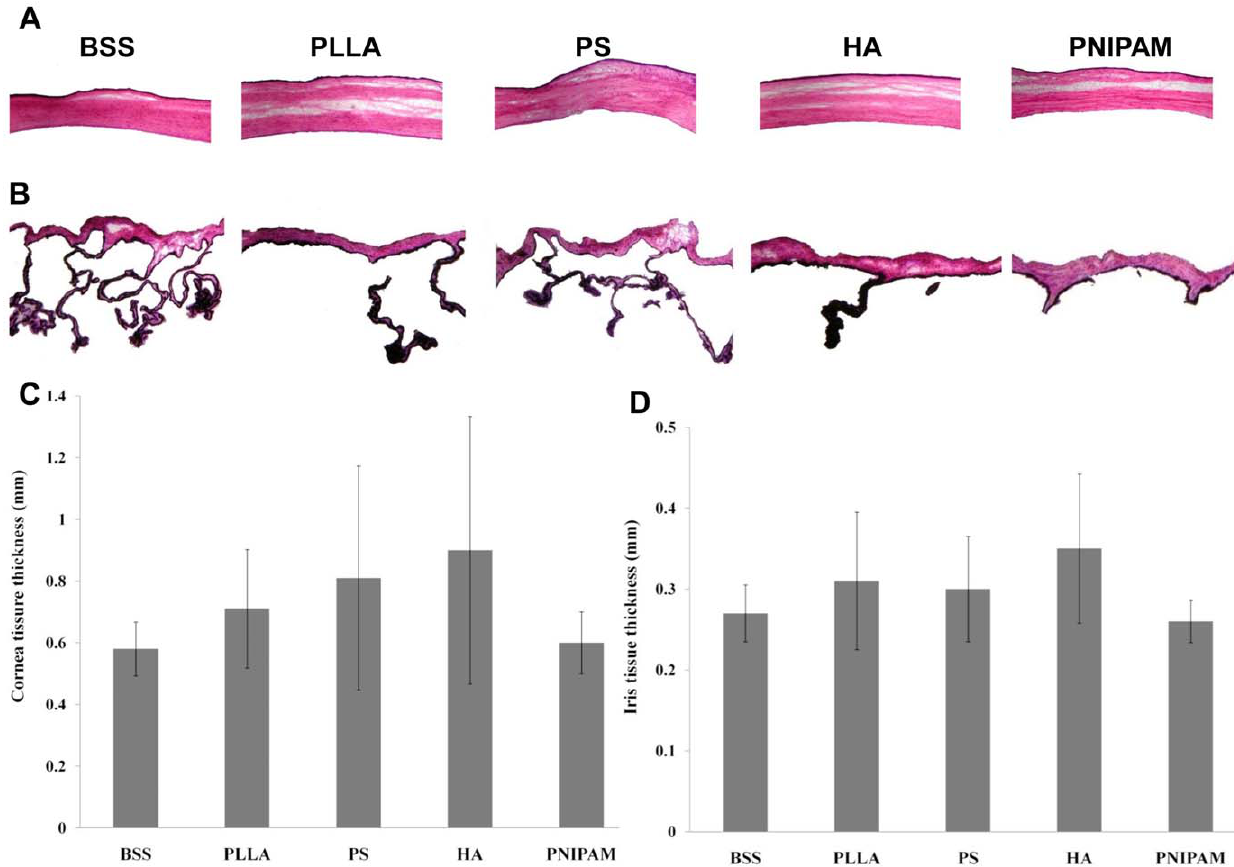
Figure 3. Histological assessment of corneal and iris tissue after intravitreous implantation. The representative H&E images of the cornea (A) and iris (B) tissue were shown here. Based on H&E staining images, the influence of particle property on the thickness of the corneal (C) and iris (D) thickness were quantified. Data are mean 6 standard deviation. Significance of PLLA, PS, HA, PNIPAM vs. BSS control; * p , 0.05.